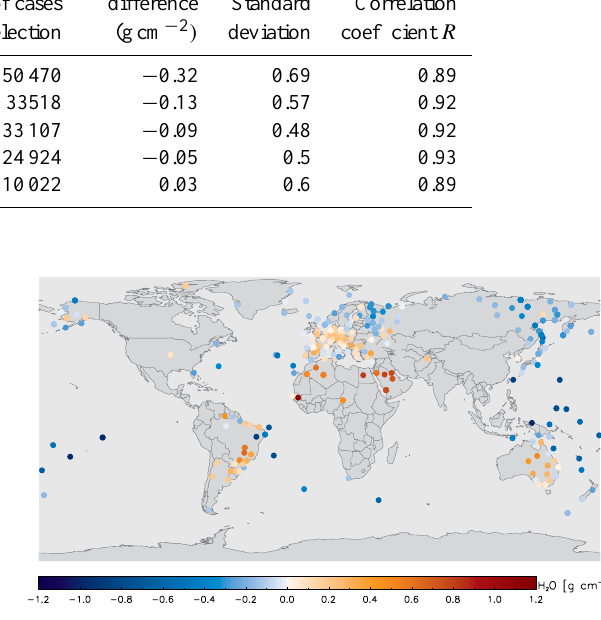
Fig. 9. SCIAMACHY-ESA and radiosonde mean WVC differ- Figure 9. SCIAMACHY-ESA and radiosonde mean WVC differences (SCIAMACHY-ESA ences (SCIAMACHY-ESA minus radiosonde WVC amounts) for minus Radiosonde WVC amounts) for the 18-month period for cloud free conditions. Each the 18-month period for cloud-free conditions. Each circle denotes circle denotes the location of a radiosonde station and the colour indicates the mean WVC the location of a radiosonde station, and the colour indicates the difference between the radiosonde and the collocated SCIAMACHY-ESA WVC mean WVC difference between the radiosonde and the collocated measurements, where the number of measurements per radiosonde station has been used as a SCIAMACHY-ESA WVC measurements, where the number of weight. measurements per radiosonde station has been used as a